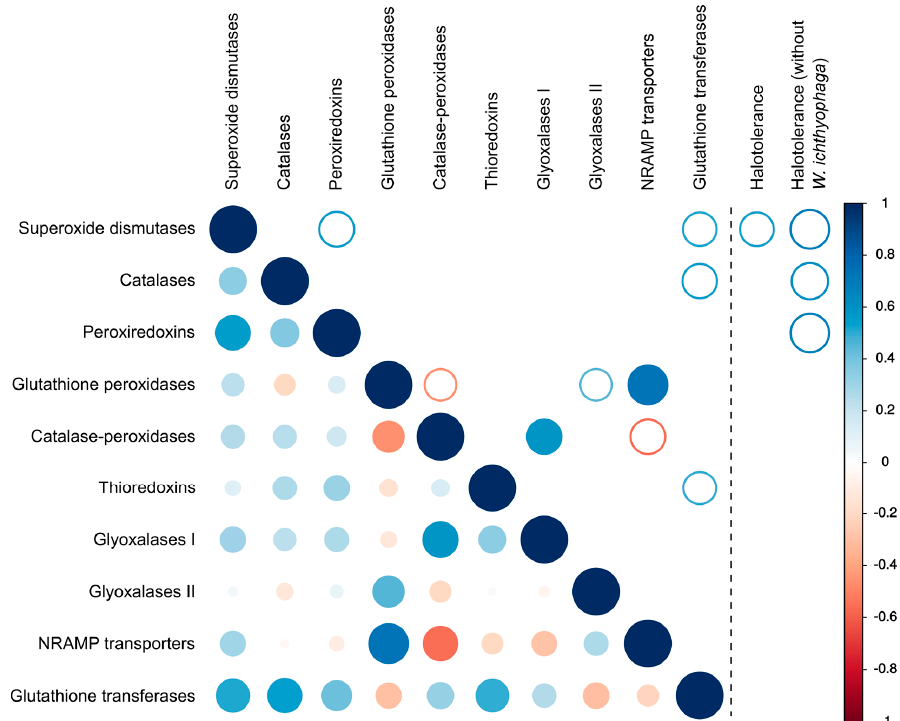
Figure 5. Correlation between the numbers of different genes involved in the oxidative stress response and between the numbers of these genes and halotolerance. Lower-left part of the matrix shows all correlations, upper right part of the matrix shows only the statistically significant correlations (full circles for p < 0.01, empty circles for p < 0.05). Right panel shows the statistically significant correlations (all with p < 0.05) between the number of genes and halotolerance expressed as the maximum salinity growth limit of each investigated species (with and without Wallemia ichthyophaga in the dataset).